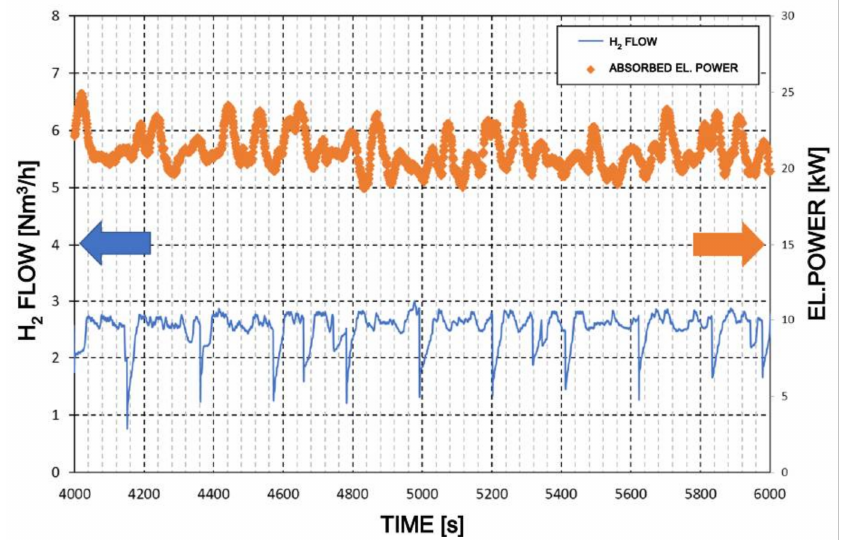
Figure 4. Plot over time of the electrical power absorbed and of the hydrogen outlet flowrate during test 4.6 bar g.